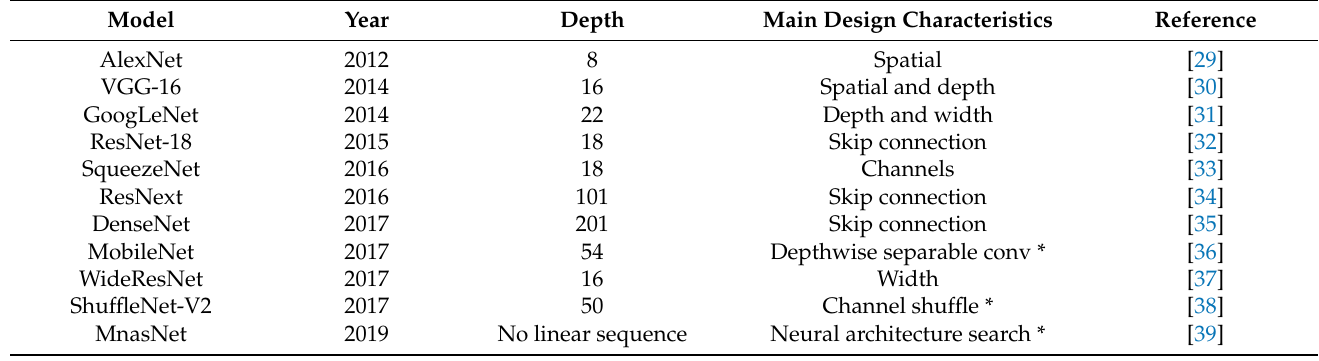
Table 1. The tested models with their main characteristics, where * refers to features specially designed for the model.